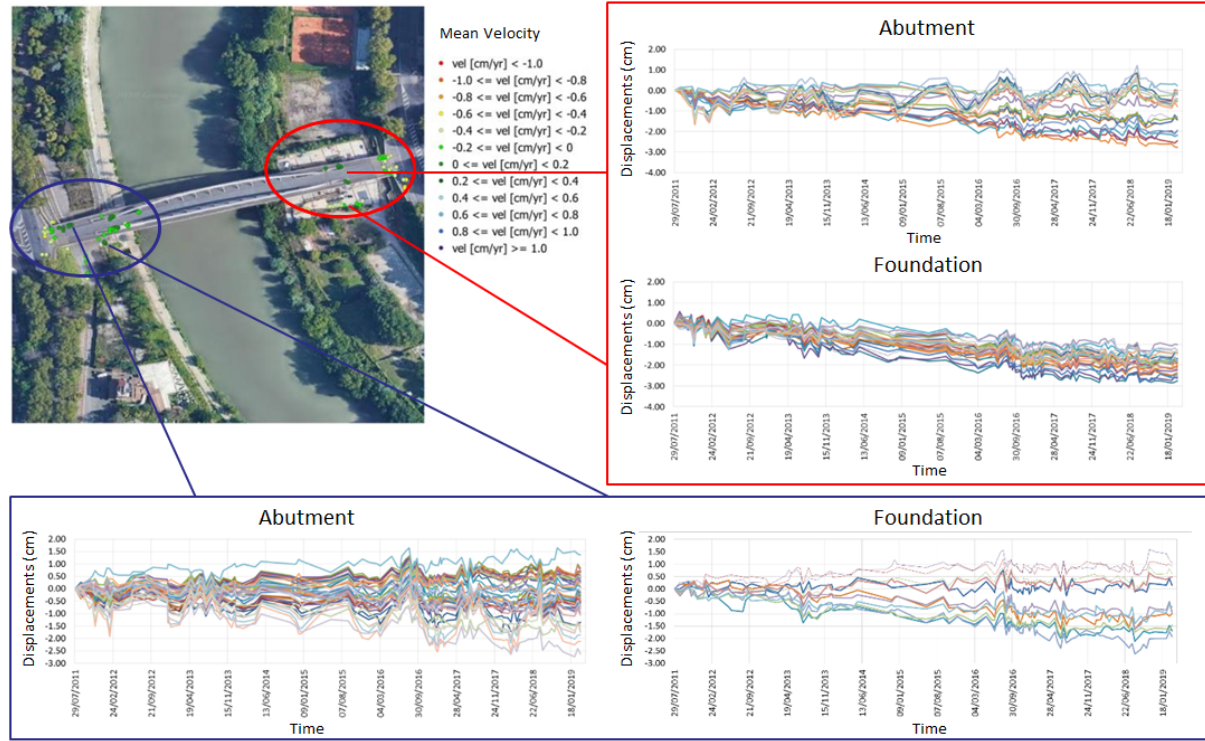
Figure 8. Displacement time-series relating to the measure points located on the bridge abutments and foundation of the west (in blue) and east (in red) bank of the Tiber river — ascending orbit.